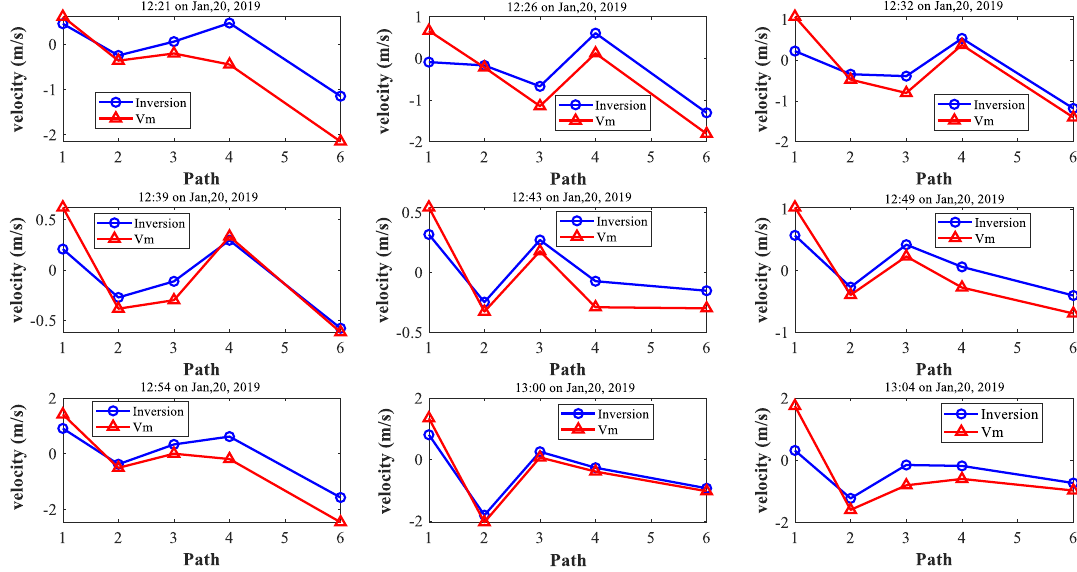
Figure 10. Comparison between the CAT inversion and the range-average velocity V m at nine moments.